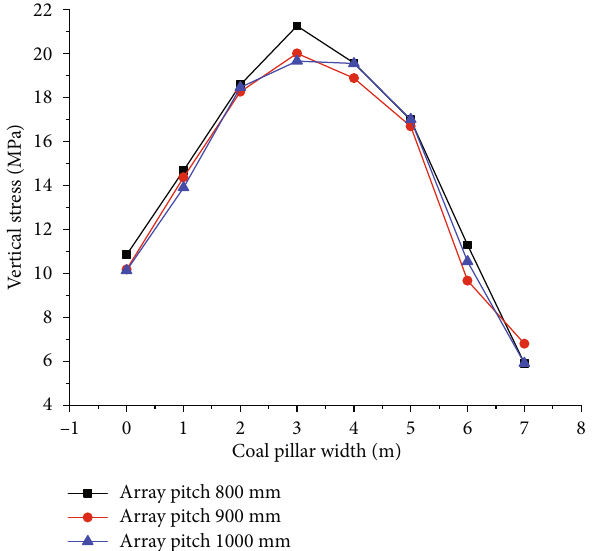
Figure 11: Vertical stress distribution law in 7 m width coal pillar under the condition of di ff erent bolt (cable) support row